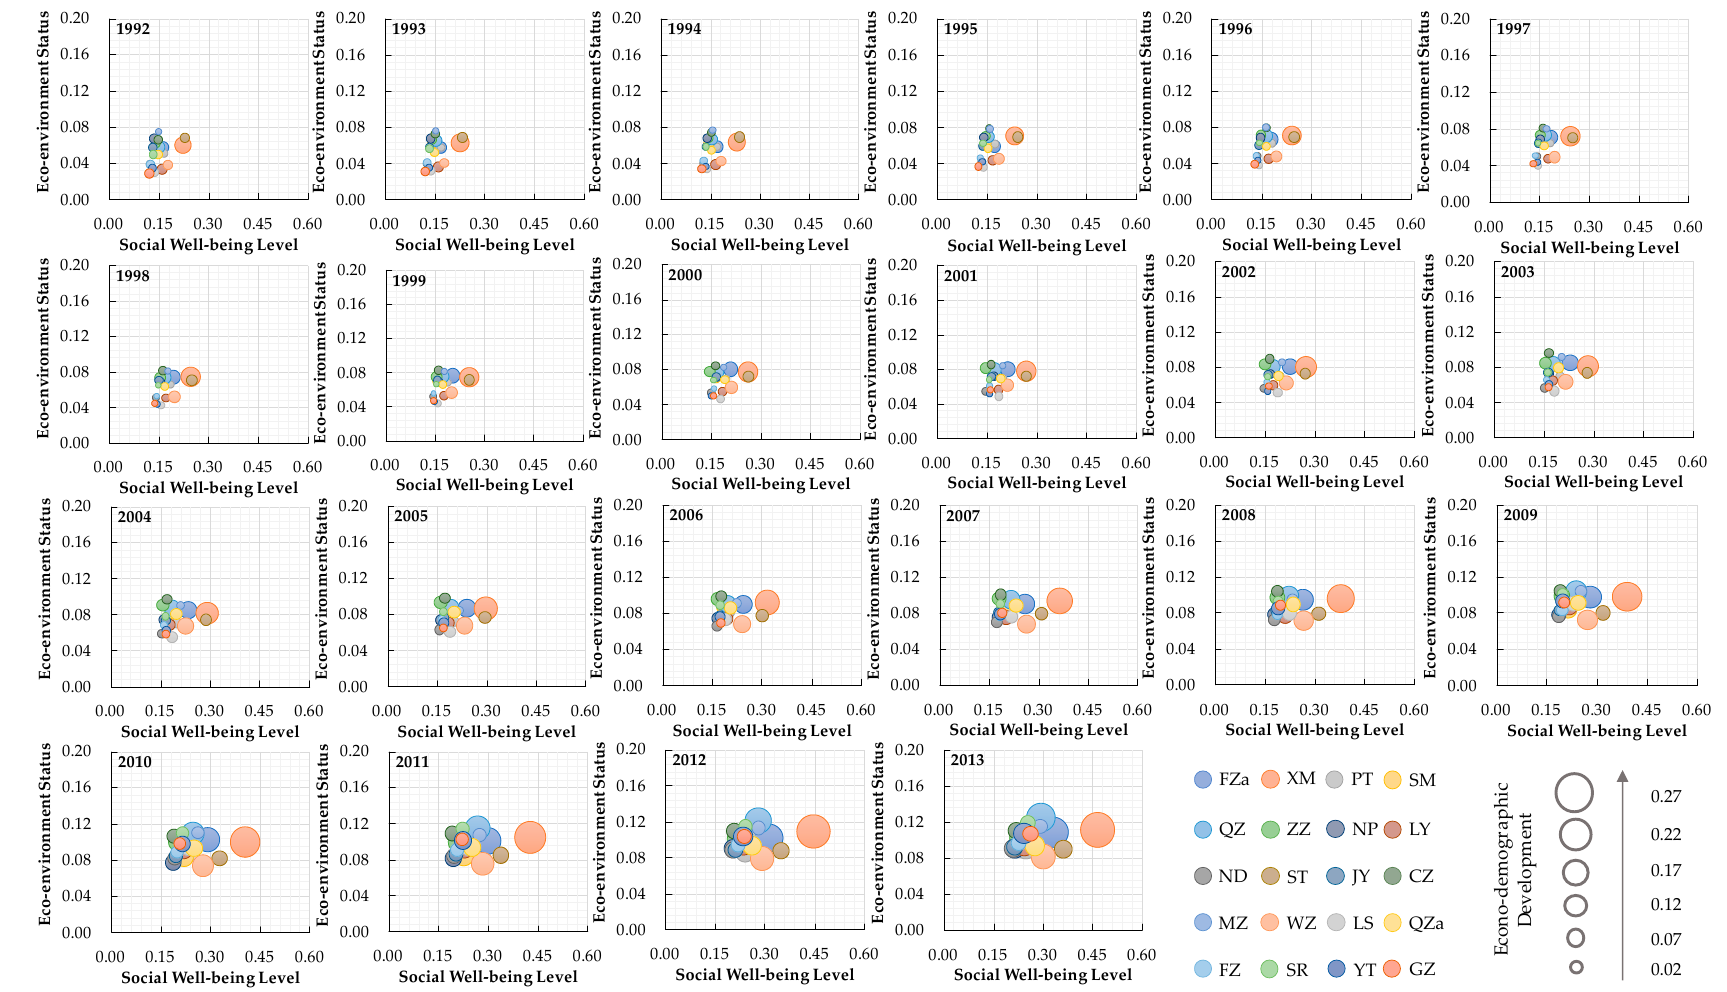
Figure 7. Urbanization quality evolution of the WTSUA from 1992 to 2013.